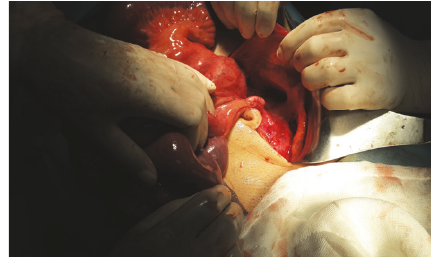
Figure 2: Retroperitoneal localized small intestines.